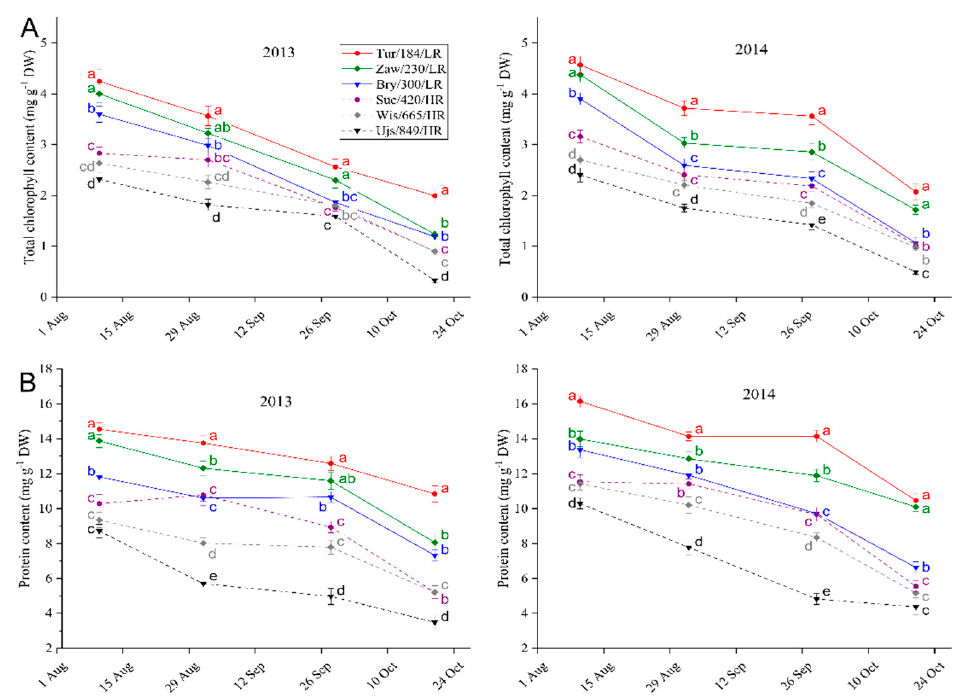
Figure 3. Changes in total chlorophyll ( A ) and protein ( B ) content in the leaves from different provenances of beech trees ( Fagus sylvatica L.). Analyses were performed for provenances from high-altitude (dashed line) and low-altitude (solid line) regions in 2013 and 2014. Each point is the mean of 15 measurements ( ± SE). Means with different lowercase letters for each sampling date differ significantly at p < 0.05. The provenance labels are: Turawa–Tur/184/LR, Zawadzkie–Zaw/230/LR, Brynek–Bry/300/LR, Sucha–Suc/420/HR, Wisła–Wis/665/HR, Ujsoły–Ujs/849/HR (Table 1).